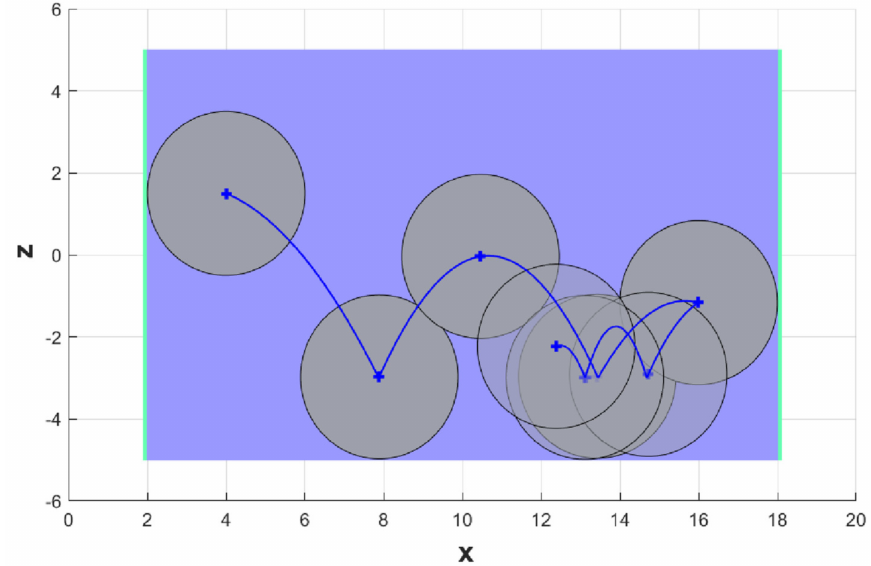
Figure 16. Evolution of the position of the balls inside the cylinder for the proposed model.